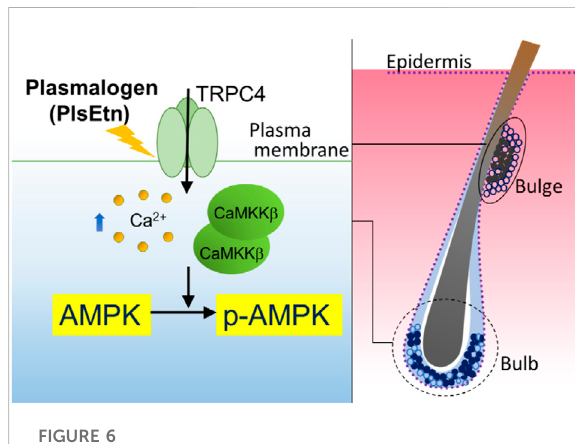
FIGURE 6 Proposed model of PlsEtn-mediated activation of AMPK in cells (left), hair bulge, and hair bulb (right). PlsEtn activate AMPK by enhancing transient Ca 2+ entry via modulation of TRPC4 channel activity in cells including HDF-a, HHDPC, and HHORSC. In stem cells of hair bulges and follicles (solid circle), PlsEtn likely induce AMPK activation via upregulation of TRPC4 channel activity, giving rise to enhance hair